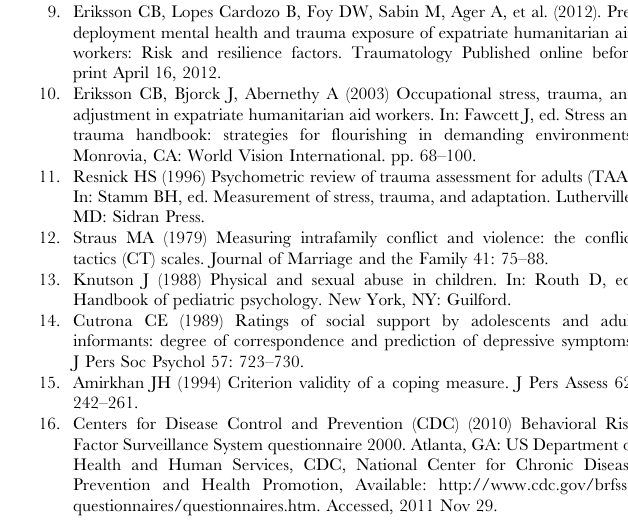
Figure S1 Life satisfaction at pre, post, and follow-up. Table S1 Overview of instruments. Table S2 Intercorrelations for scores of outcome vari- ables at 3 time points. Table S3 Unadjusted bivariate analysis of mental health outcomes and burnout subscales versus risk/ mitigating factors. Table S4 Longitudinal multivariate generalized esti- mating equations model: demographic variables, expo- sure, organizational and other risk and mitigating factors affecting life satisfaction. Table S5 Job satisfaction versus risk/mitigating factors at